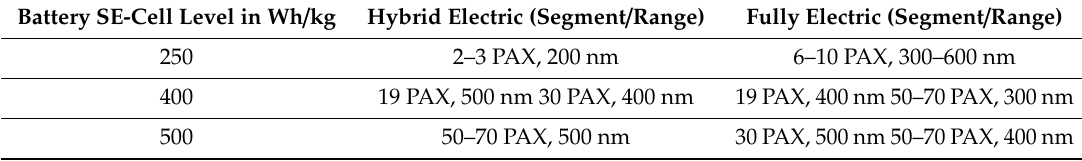
Table 10. Payload / range projection for fully / hybrid electric